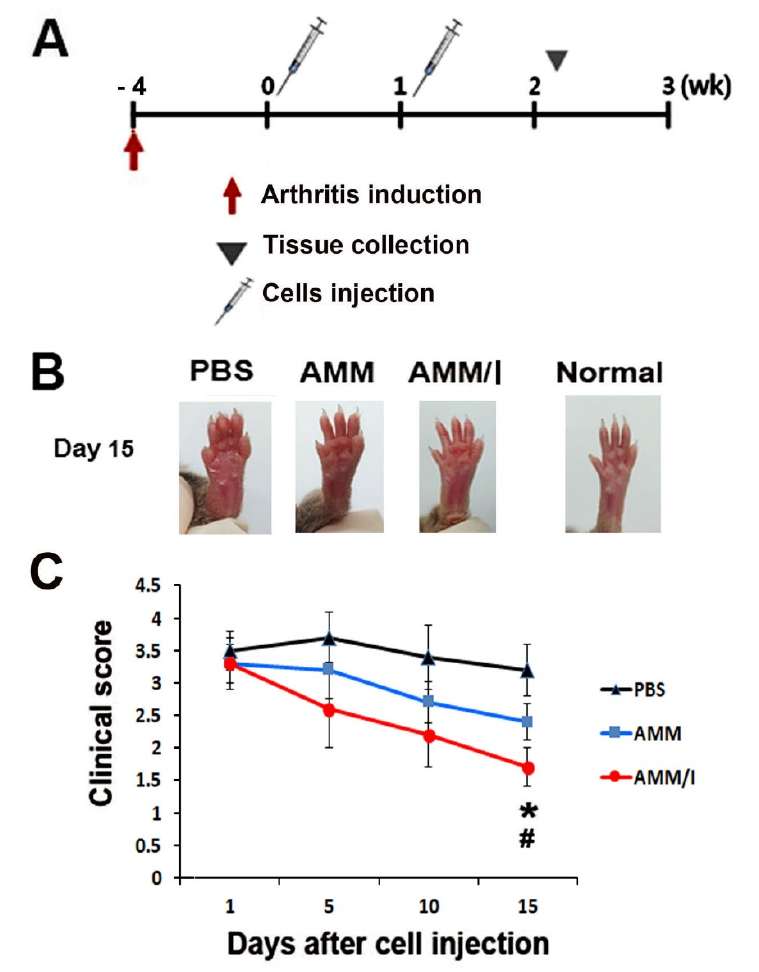
Figure 2. AMM/I transplantation leads to the prevention of disease progression. ( A ) Schematic rep- resentation of the procedures for the induction of arthritis, cell injection, and collection of specimens. ( B ) Representative pictures of mice paws after cell injection. ( C ) Quantification of arthritis scores. The arthritis scores were measured using severe swelling paws. # p < 0.01 AMM/I vs. PBS,* p < 0.05 AMM vs. AMM/I, n = 5 per group.